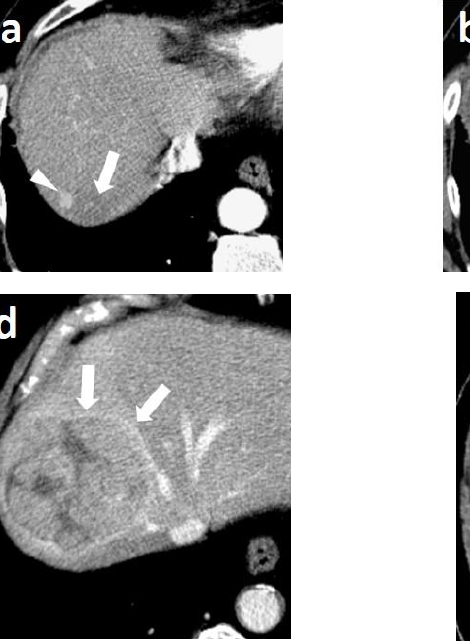
Figure 6. Ancillary imaging features for HCC assessment. Nodule-in-nodule architecture, mosaic ar- chitecture, and corona enhancement on the late arterial and portal-venous phase, respectively. MDCT axial images. ( a , b ): A small nodule (arrowhead) is located at the periphery inside a larger nodule (arrow), with APHE ( a ) and “wash-out” ( b ) on PVP. The parent nodule is not enhancing. ( c , d ): A heterogeneous mass, characterized by enhancing compartments and necrotic areas is seen ( c ). An en- hancing capsule is depicted on PVP ( d ) (arrows). ( e , f ): There is a transient zone of hyperenhancement around the outer margin of the nodule ( e ) (arrowheads), which fades on PVP ( f